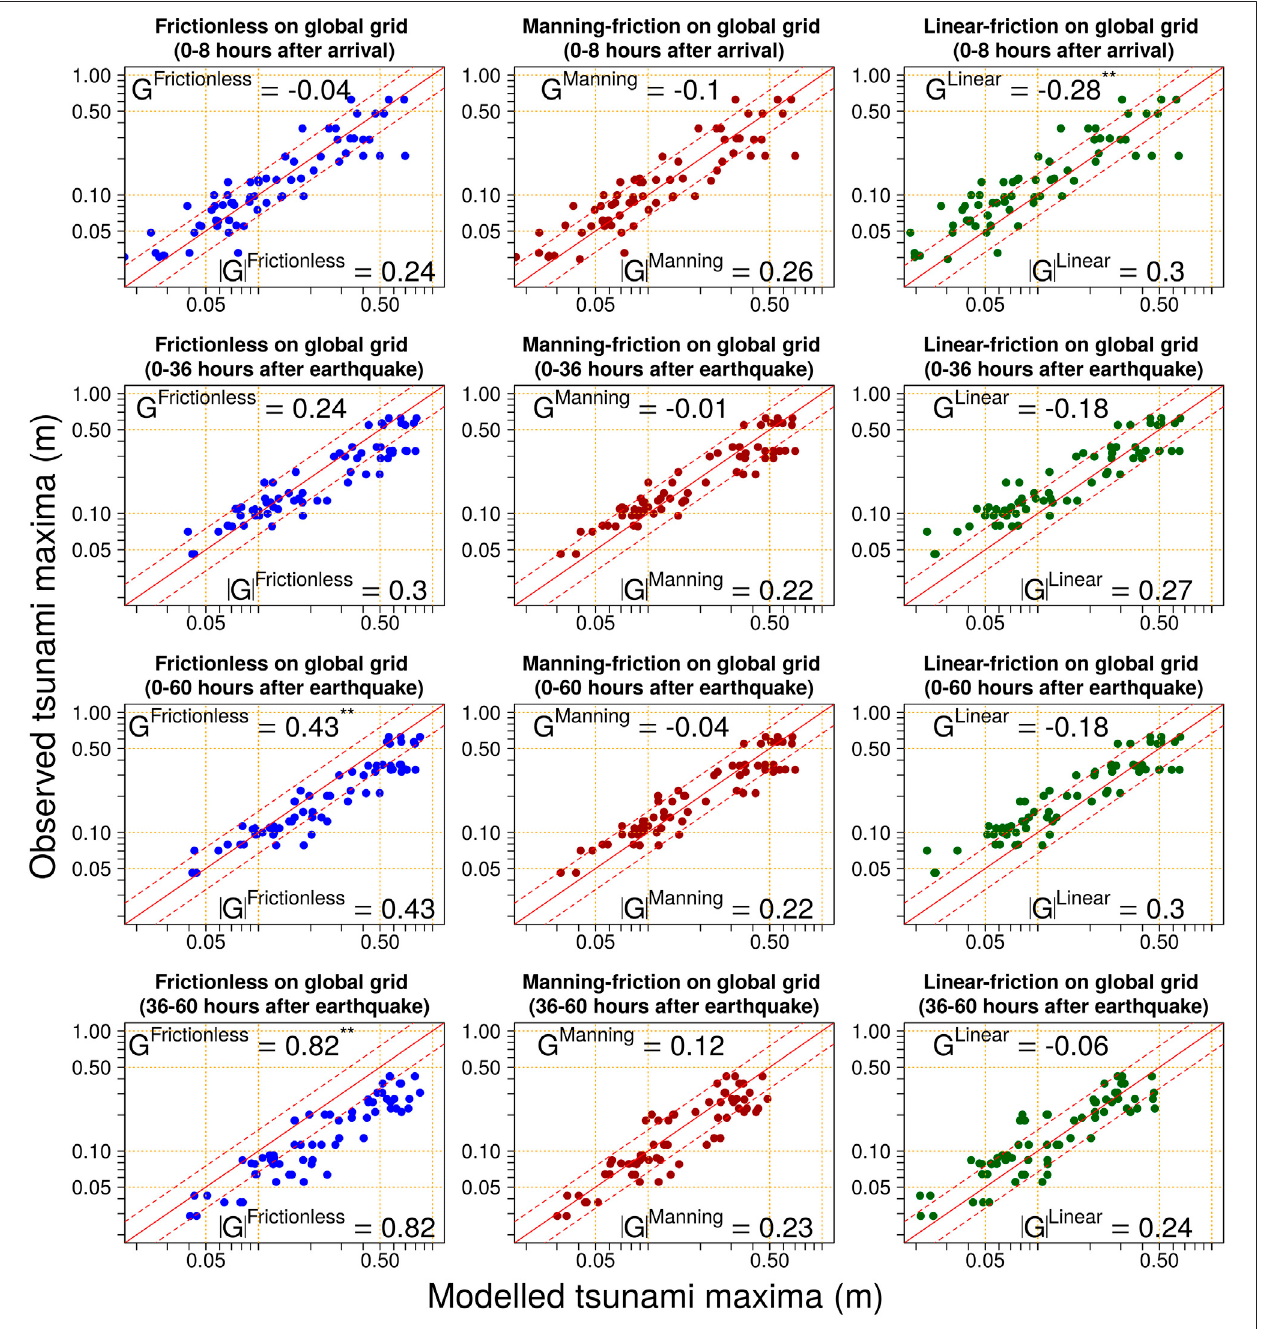
FIGURE 10 | Modelled-vs-observed tsunami maxima for different global model types (frictionless, Manning-friction, linear-friction), and different temporal subsets of the simulation (0 – 8 h after tsunami arrival; 0 – 36 h after earthquake; 0 – 60 h after earthquake, 36 – 60 h after earthquake). Diagonal solid line is y (cid:2) x ; diagonal dashed lines are y (cid:2) 1 . 5 x and y (cid:2) x / 1 . 5. Where the G m values are followed by **, there were 10 or more source-inversions having G m i values of the same